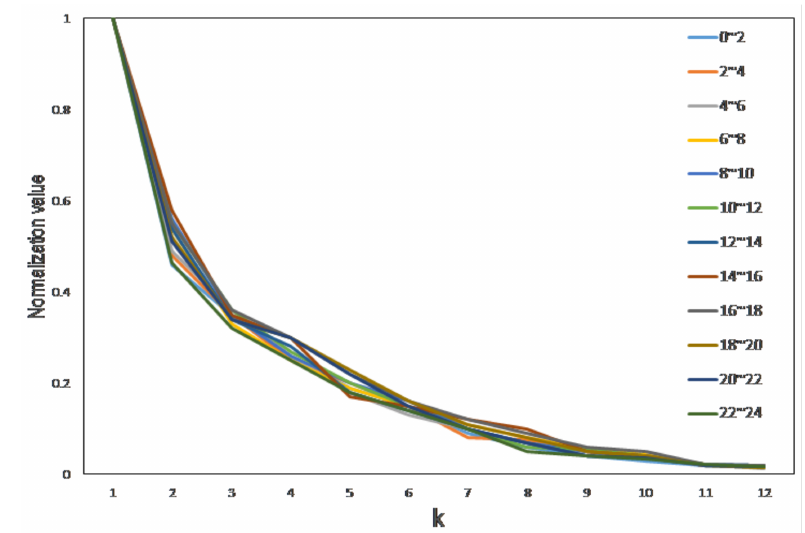
Figure 4. Best k-value chosen by elbow method in different periods.